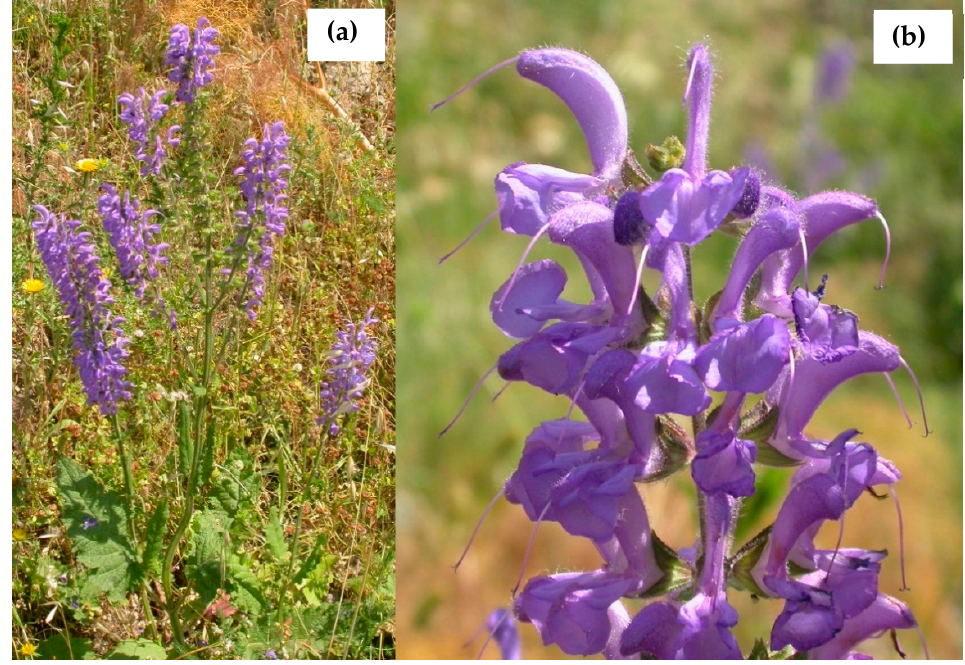
Figure 1. Salvia haematodes L. from Calabria (Southern Italy): ( a ) full plant in flower, and ( b ) inflorescence.